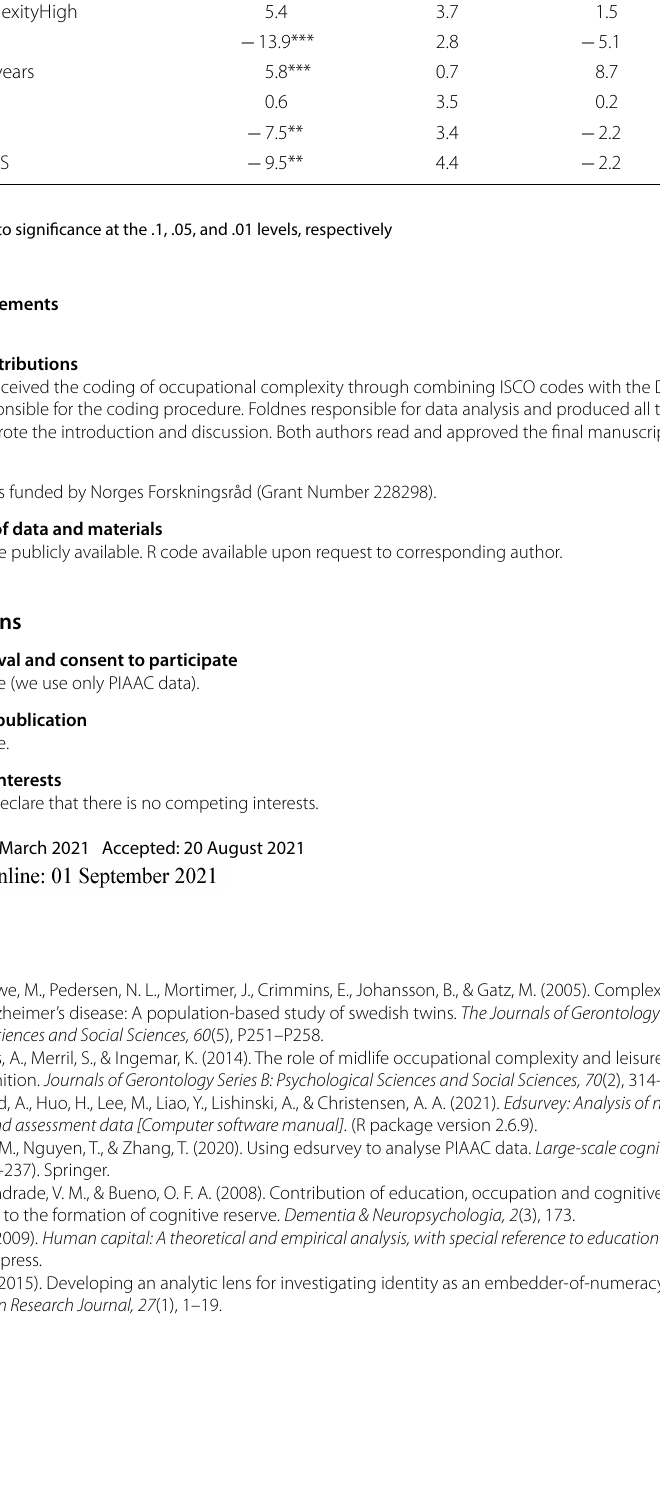
R 2 = 0.2 *, **, *** refer to significance at the .1, .05, and .01 levels, respectively